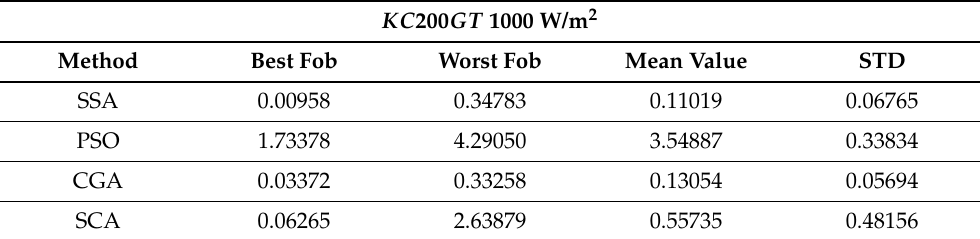
Table 6. Results obtained for the KC 200 GT PV panel under a 1000 W/m 2 irradiance